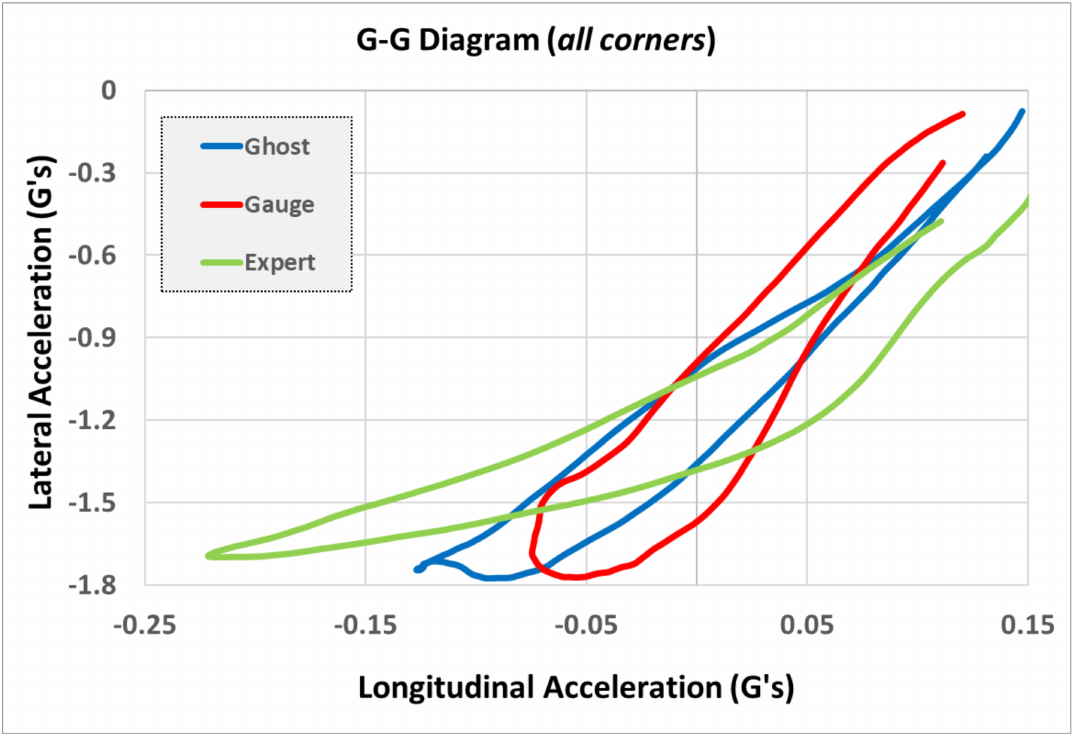
Figure 18. Ghost vs. gauge G − G diagram (averaged across all